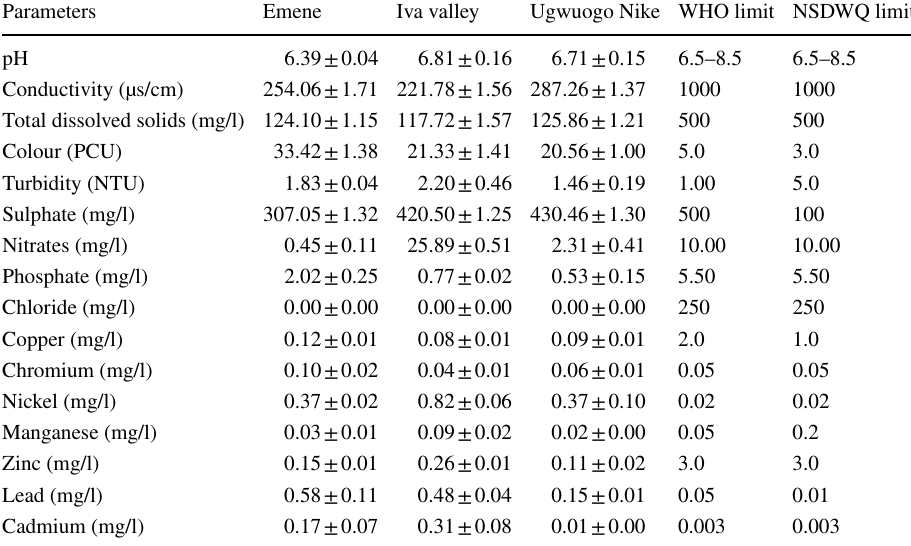
Table 2 Mean values of physicochemical parameters of the non-roof harvested rainwater with WHO, NSDWQ